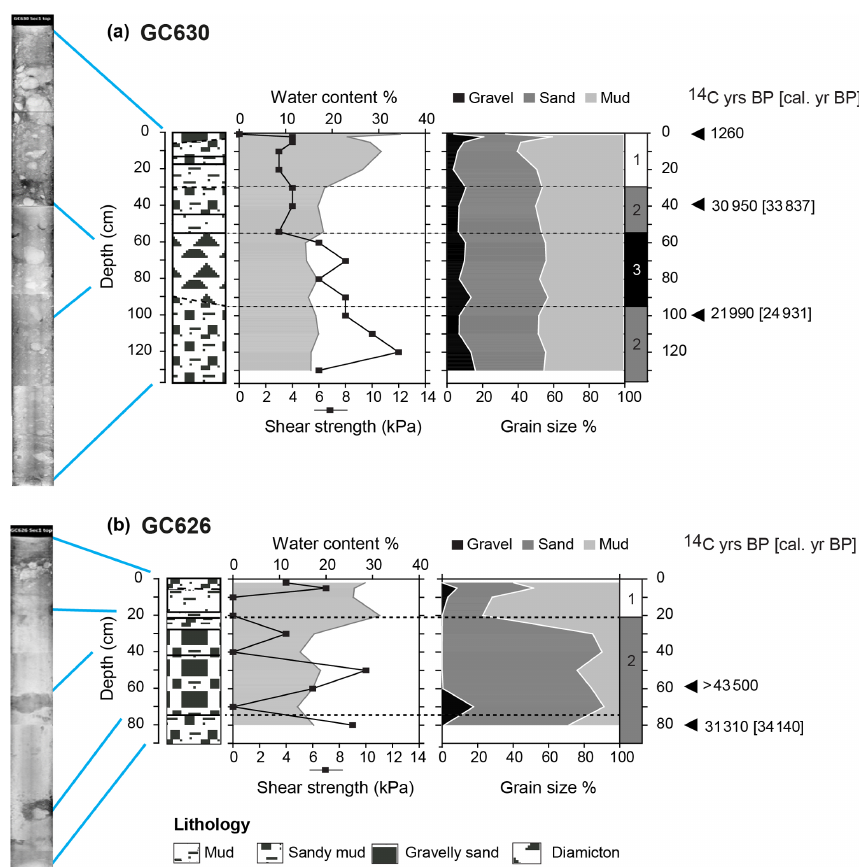
Figure 9. X-ray images, lithology, shear strength, water content and grain size analyses for sediment cores. (a) GC630 from the crest of the GZW in the Dawson-Lambton Trough. The core consists of stratified pebbly/sandy muds at its base (137.5–90cm) overlain by a massive a muddy diamicton (90–55.5cm) and then a sequence of gravelly sands and sandy muds (55.5–0cm). Shear strength generally increases downcore, reaching a maximum of 12kPa. (b) GC626 on the distal side of the GZW. The core consists of a sequence of a sandy mud at its base (90–75cm) with dispersed foraminifera throughout, overlain by normally graded foraminifera-bearing gravel to muddy sand (75–22cm). Above this (22–0cm) is a homogenous sandy mud, with dispersed gravel grains in the top